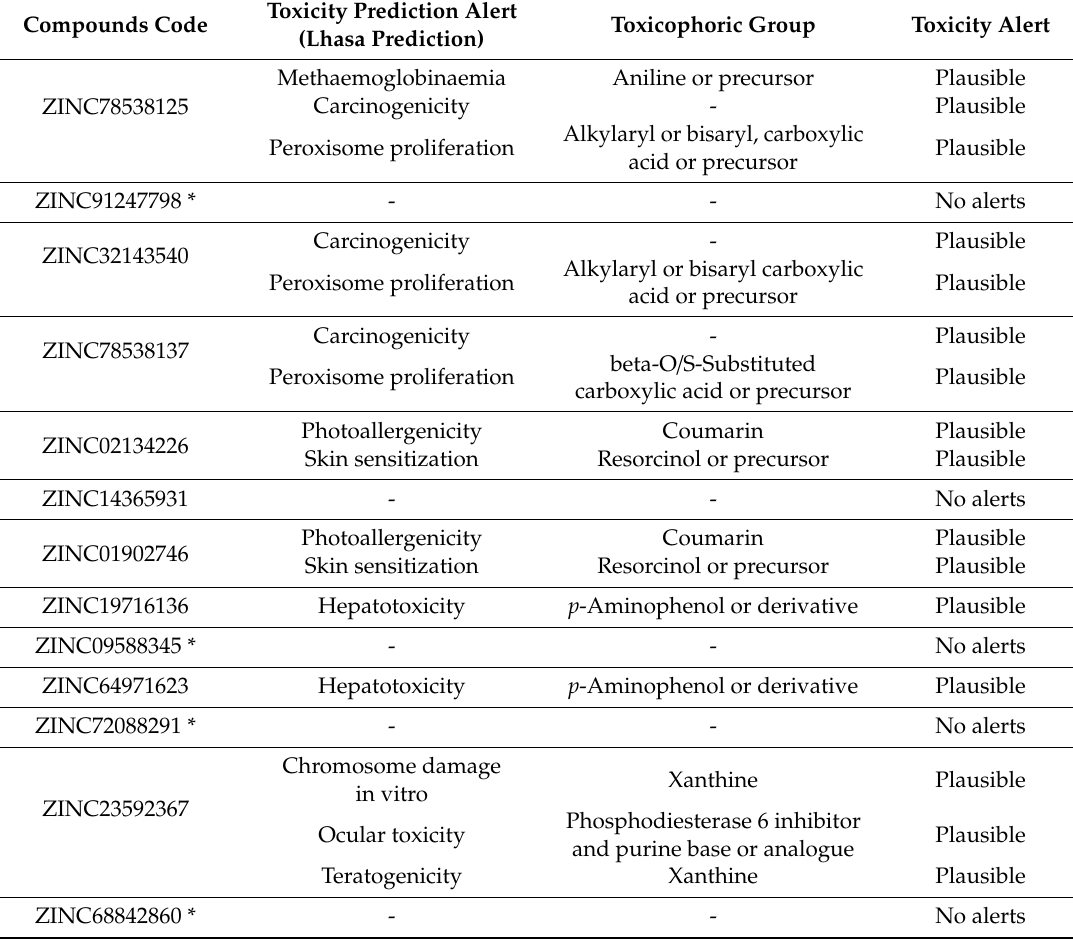
Table 6. Toxicity prediction by toxicophoric